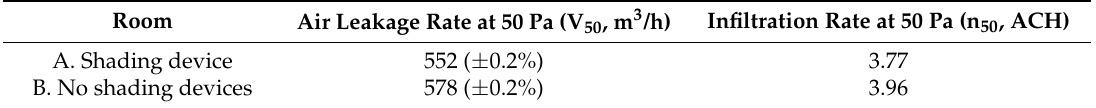
Table 3. Infiltration test results.